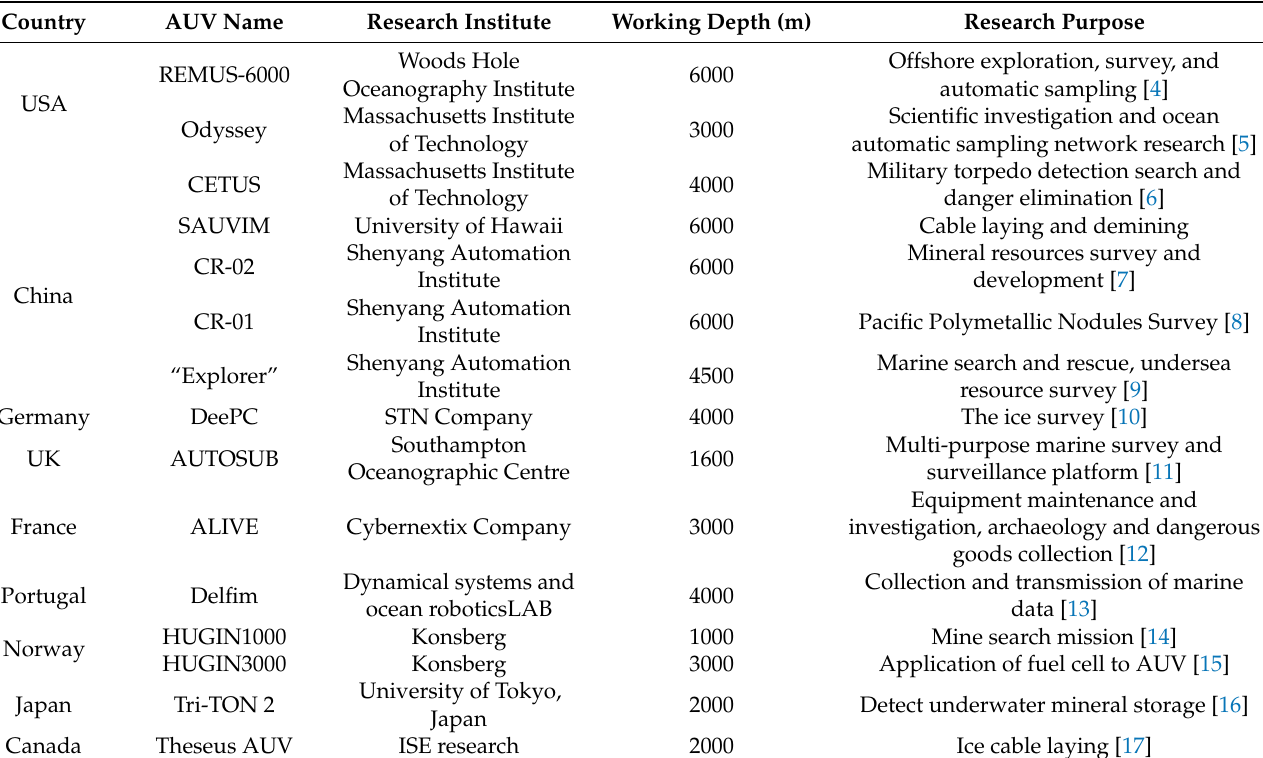
Table 1. AUVs and its application in various